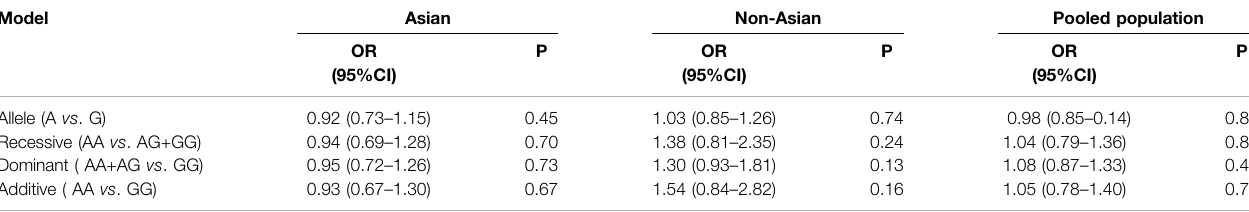
OR P OR P OR P (95%CI) (95%CI) (95%CI)